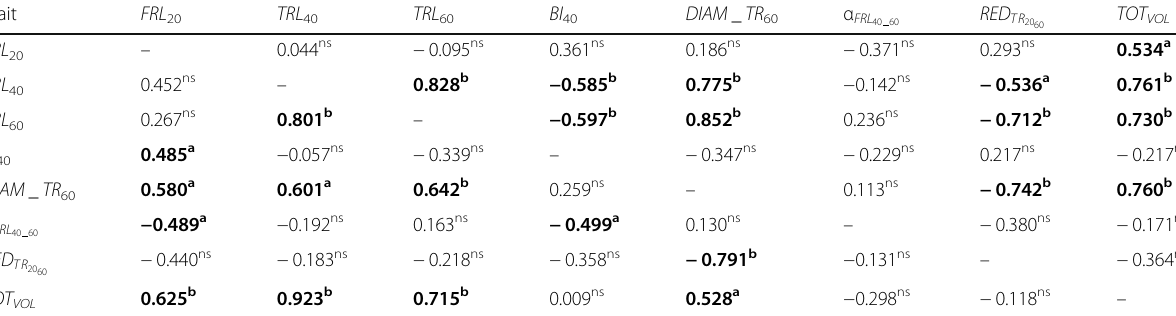
Table 4 Phenotypic correlations for the 8 selected root traits among the 17 rice accessions under two water conditions